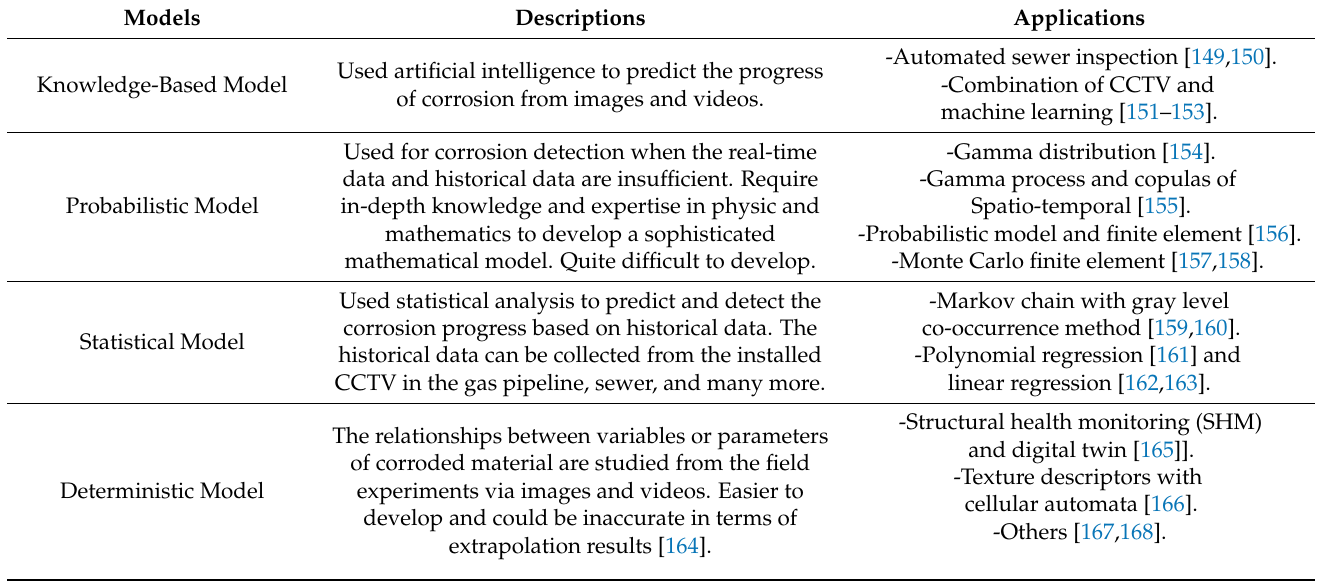
Figure 9. Computer vision and image processing elements. Table 3. Short description of different corrosion detection approaches and their applications.